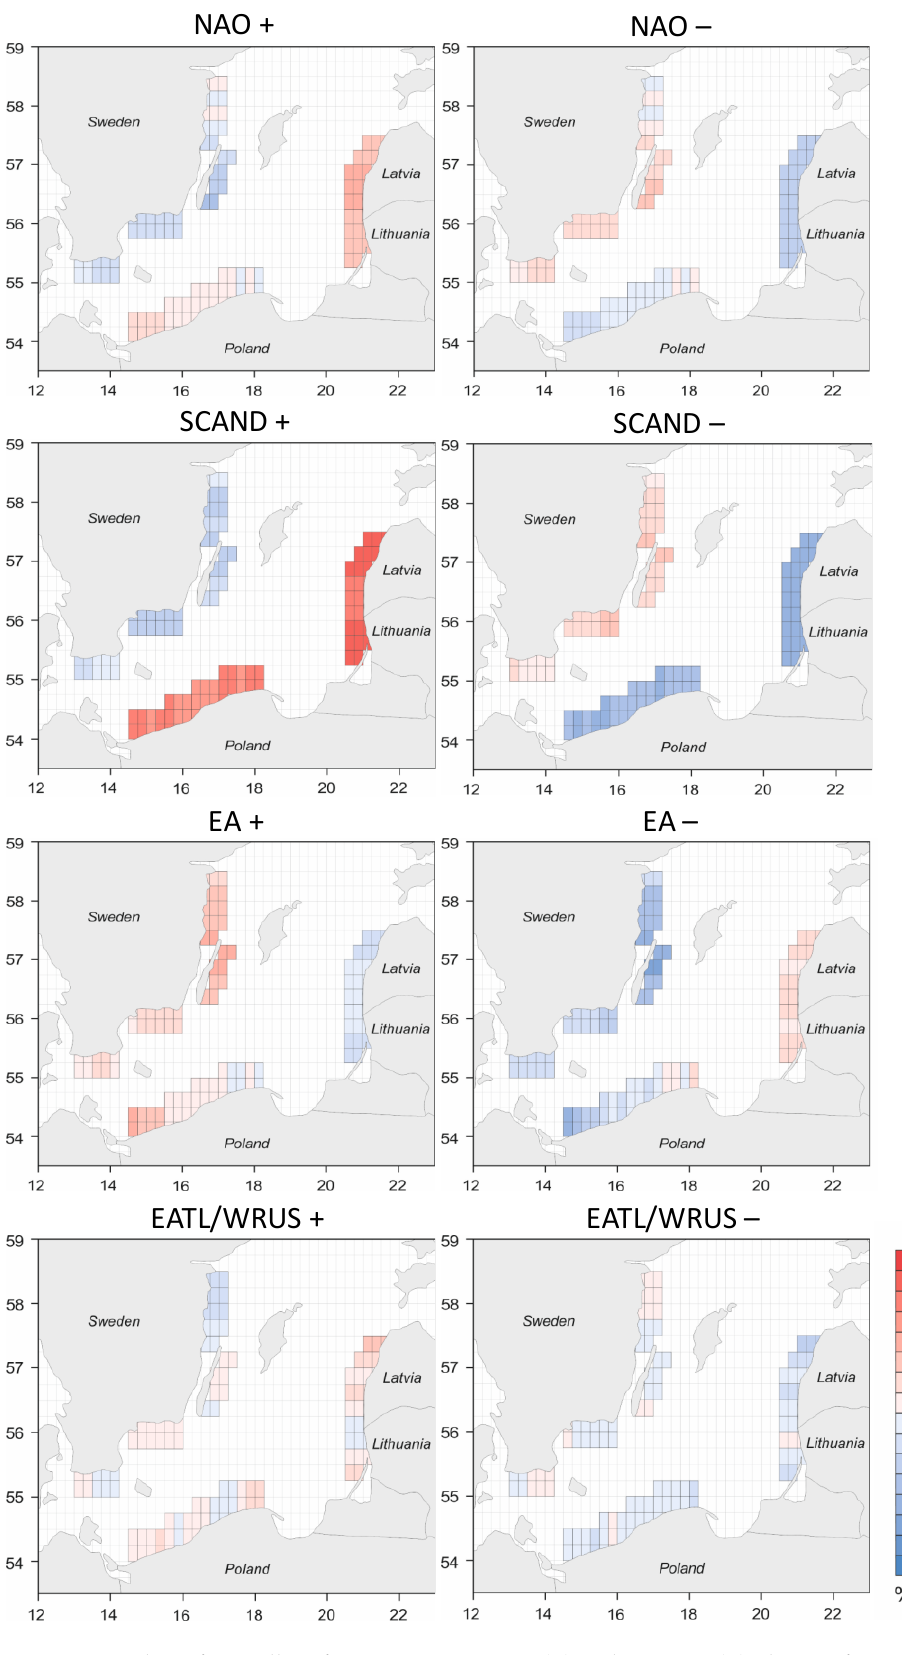
Figure 6. Anomalies of upwelling frequency in positive ( + ) and negative ( − ) phases of macroscale circulation patterns.